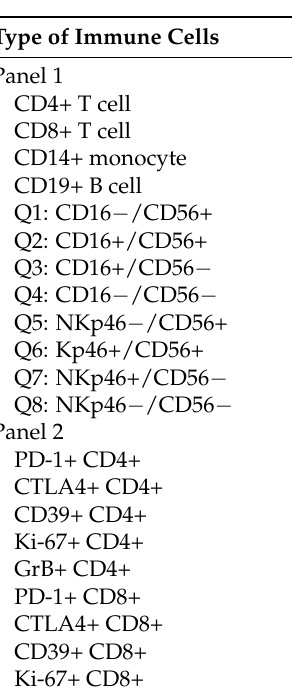
Table 2. The change of the immune cell fraction.